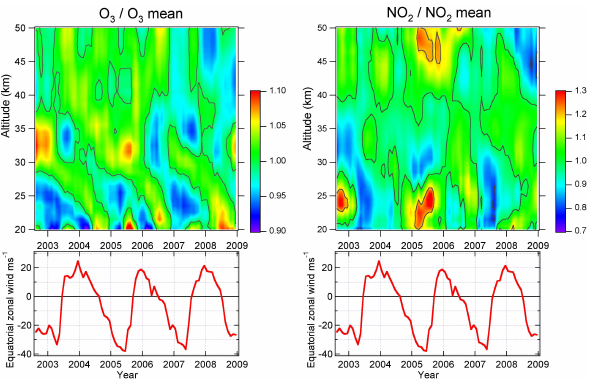
Fig. 6. Top) Evolution of NO 3 mixing ratio and ECMWF tempera- ture in the latitude band 15 ◦ S–15 ◦ N their mean value at the given altitude for the full period. The plot is limited to altitude range 27– 48km to exclude regions where the signal to noise ratio in NO 3 mixing ratio is to poor; Bottom) Equatorial zonal wind at 10hPa updated from Naujokat